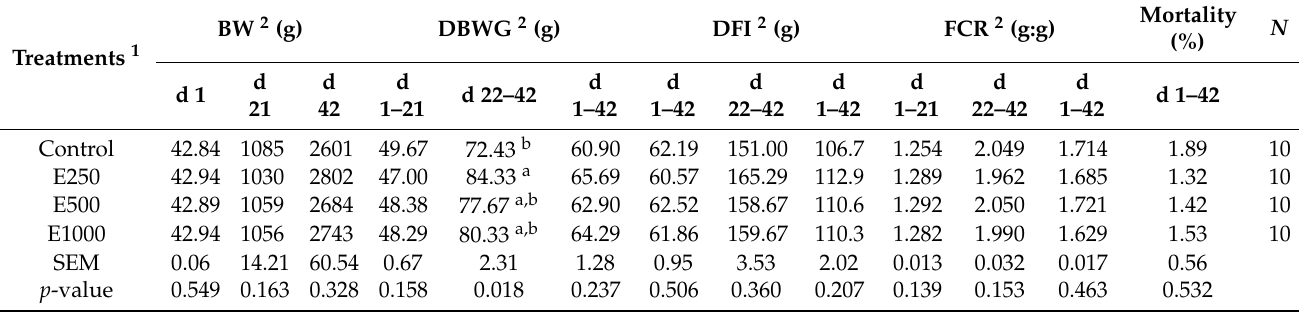
Table 2. Effect of glucose oxidase addition on the performance of